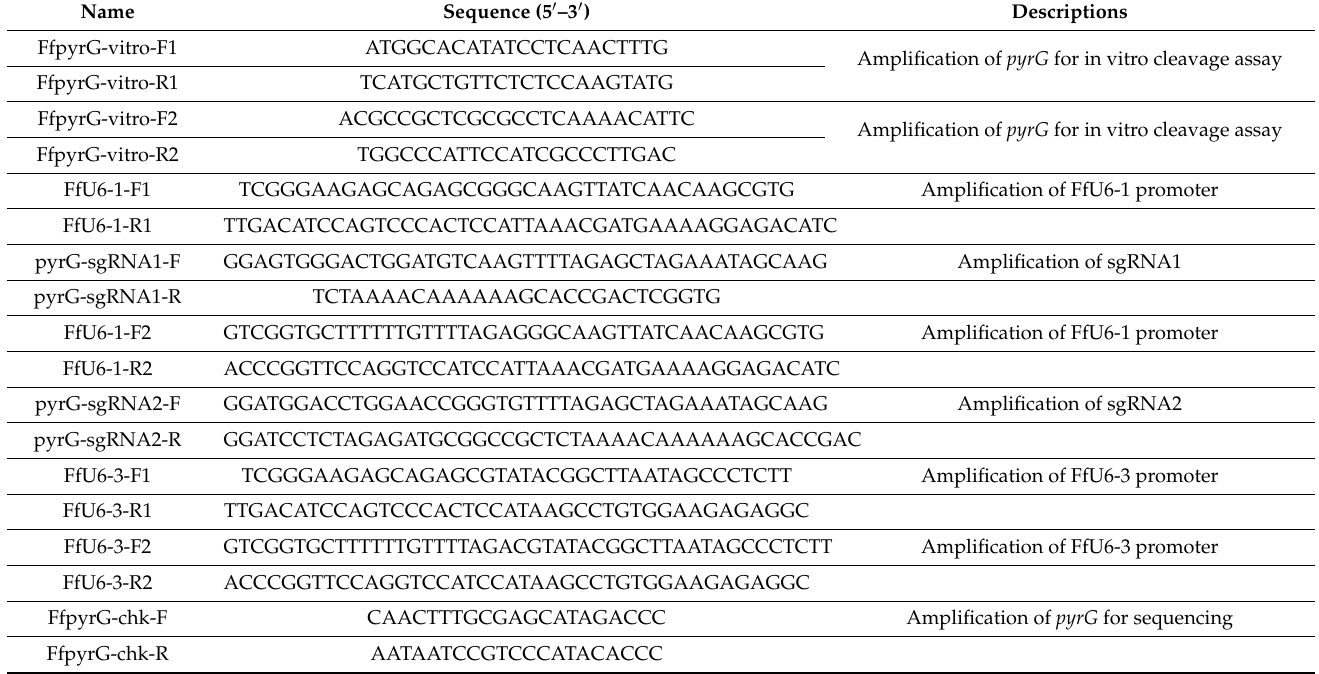
Table 1. List of oligonucleotides used in this